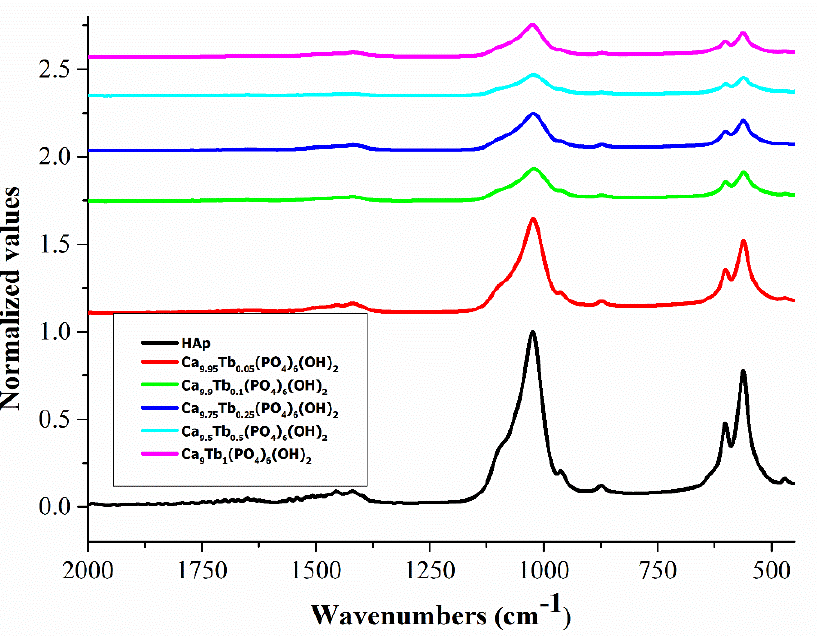
Figure 1. Normalized FTIR spectra of hydroxyapatite (HAp) and Ca 10 − x Tb x (PO 4 ) 6 (OH) 2.